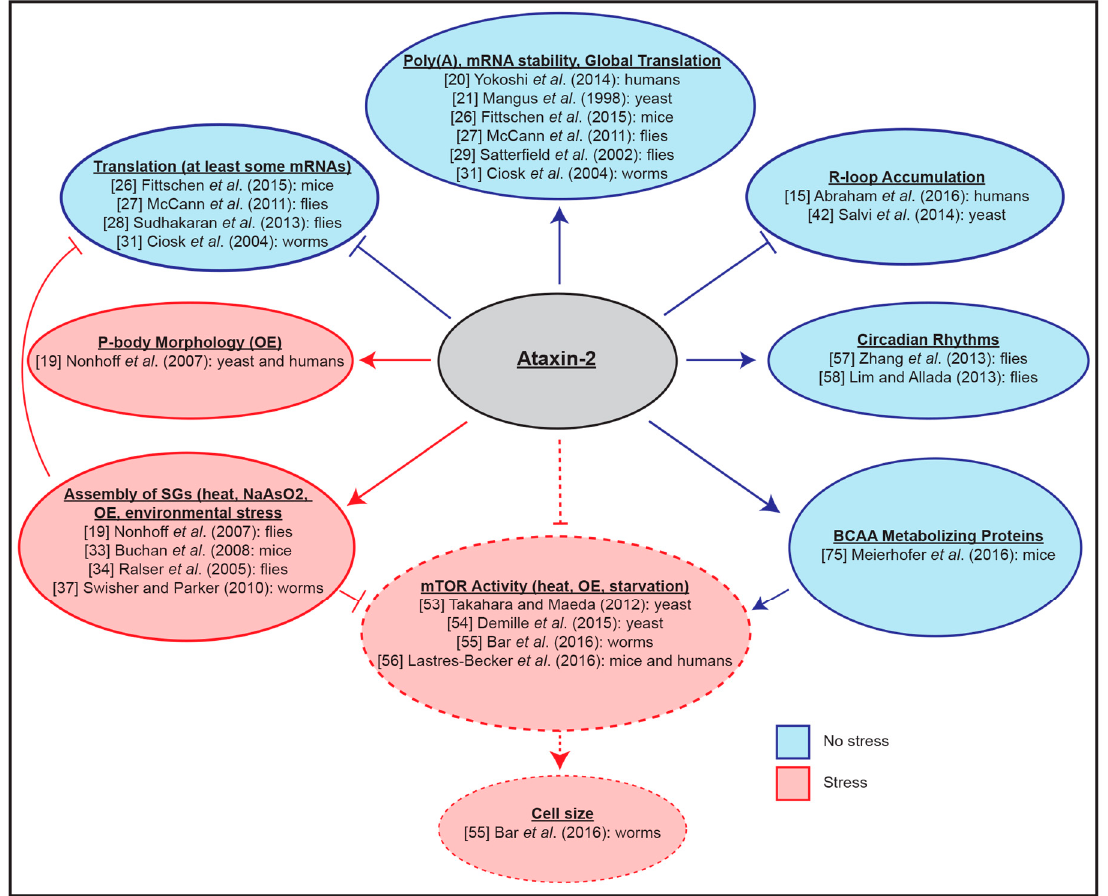
Figure 2. Functions of Ataxin-2 proteins under stressed and non-stressed conditions. Studies from a variety of model organisms demonstrate a role for Ataxin-2 proteins in the regulation of mRNA polyadentylation, stability, translation, R-loops, circadian rhythms, branched-chain amino acid (BCAA) metabolism, mTOR activity, stress granule (SG) assembly, and P-body morphology. Dashed lines represent indirect regulation by Ataxin-2. Reference numbers for papers are shown.